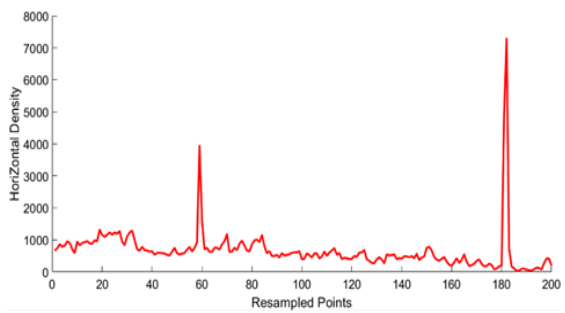
Figure 11. Diagram of horizontal density of a line which located on a cable area.